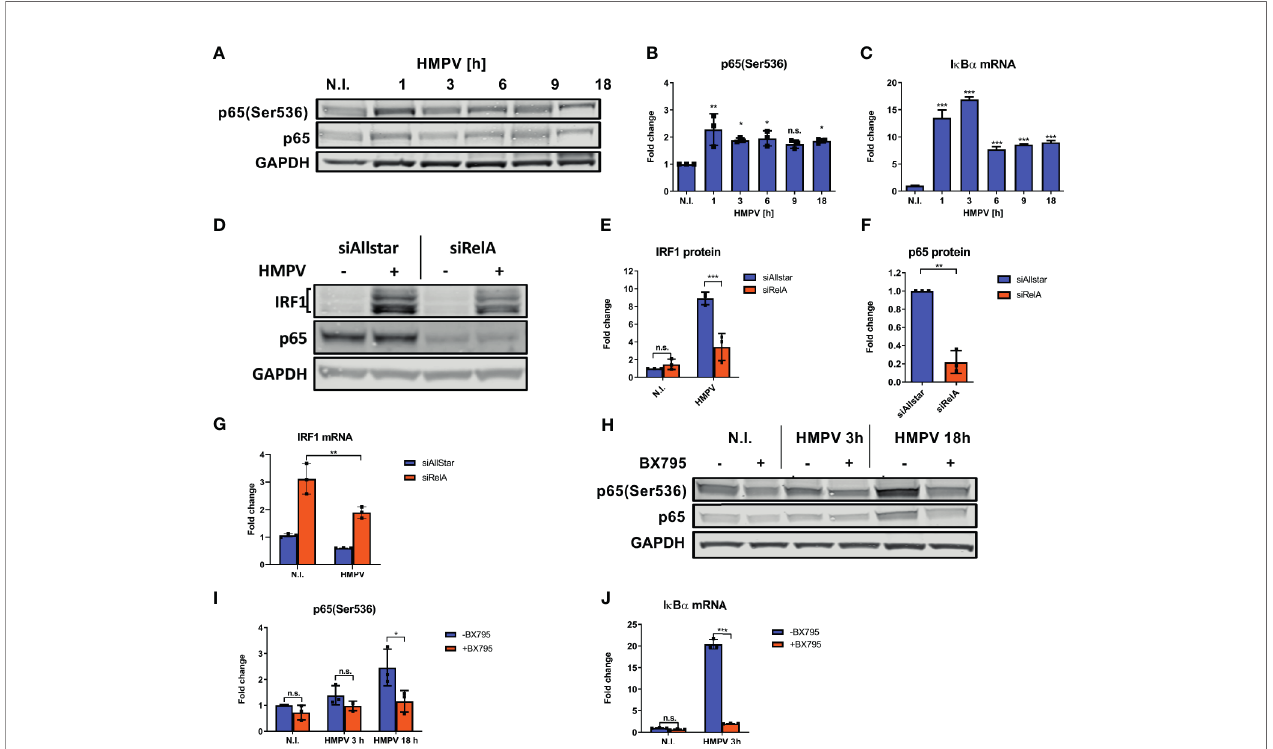
FIGURE 4 | NF- k B is necessary for HMPV-induced IRF1 expression. (A – C) Human MDMs were infected for the indicated timepoints with HMPV or treated with medium (N.I.). (A) Whole cell lysates were prepared and protein levels of p65 and p-p65(Ser536) were analyzed by immunoblotting. (B) Protein levels were quanti fi ed by normalization of band intensities against GAPDH and are presented as fold change relative to uninfected cells ( “ N.I. ” ). (C) I k B a mRNA expression was determined by qRT-PCR. Error bars represent SD of three technical replicates. (D – G) MDMs were transfected with RelA siRNA or control siRNA («Allstar») prior to infection with HMPV. In (D – F) whole cell lysates were prepared and protein levels of IRF1, p65 and GAPDH were analyzed by immunoblotting. For (E, F) , protein levels were quanti fi ed by normalization of band intensities against siAllstar medium and the respective values for GAPDH. (G) IRF1 mRNA in siRNA-treated MDMs was determined by qRT-PCR. (H – J) Human MDMs were pretreated with or without BX795 before infection with HMPV for the indicated timepoints. Whole cell lysates were prepared and protein levels of p65, p-p65(Ser536) and I k B a were analyzed by immunoblotting (H) . Protein levels were quanti fi ed by normalization of band intensities against GAPDH and are presented as fold change relative to uninfected cells ( “ N.I. ” ; I ). (J) I k B a mRNA expression was determined by qRT-PCR. Error bars represent SD of three technical replicates. Statistical analysis: Two-way ANOVA with Tukey ’ s honest signi fi cance test ∗ p < 0.05; ∗∗ p < 0.01; ∗∗∗ p < 0.001; n.s., not signi fi